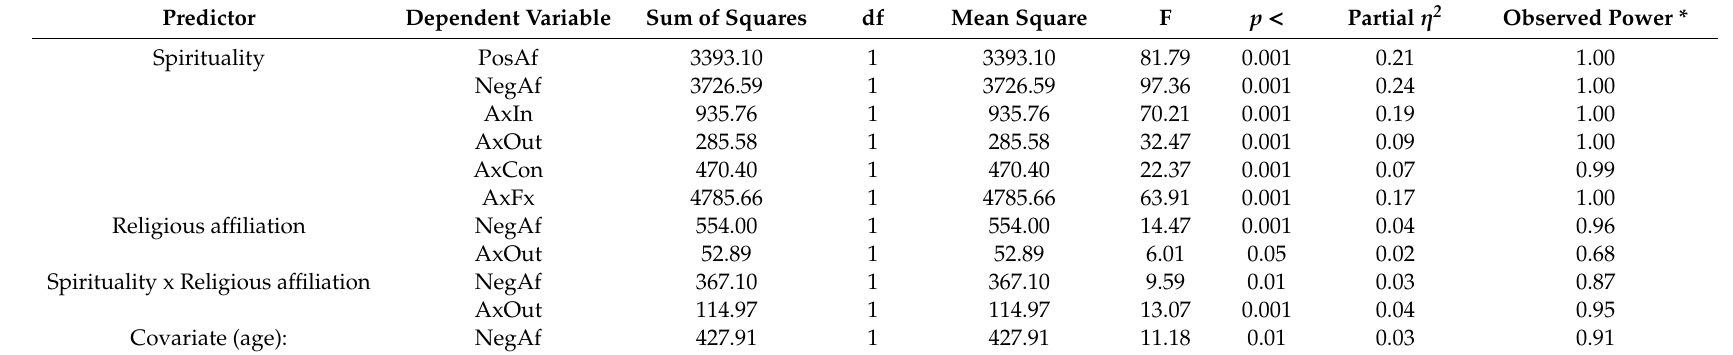
Table 4. The e ff ect of spirituality and religious a ffi liation on emotional